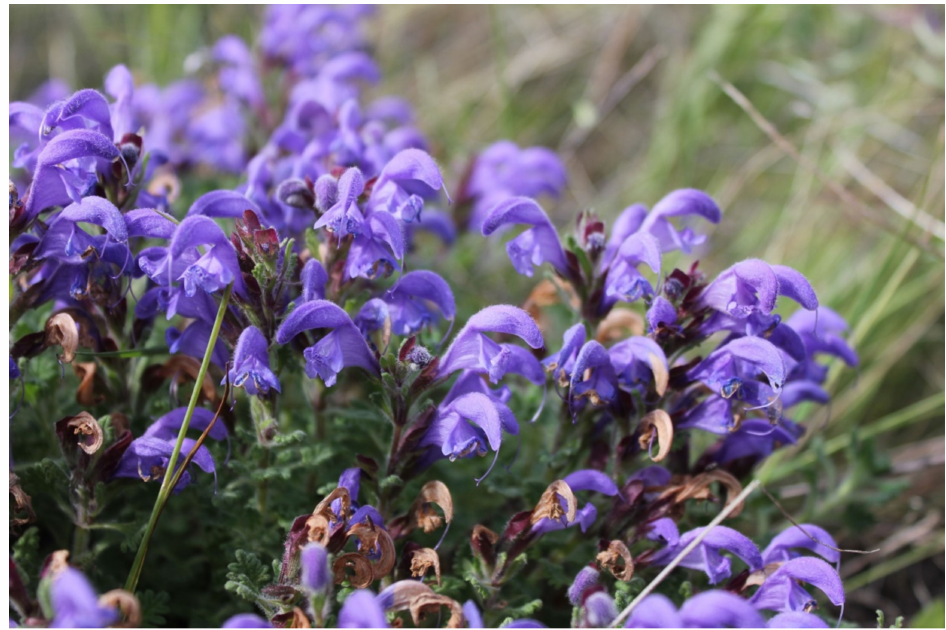
Figure 1. Dracocephalum palmatum S. in the Oymyakon area of Yakutia (photo taken by Okhlopkova, July